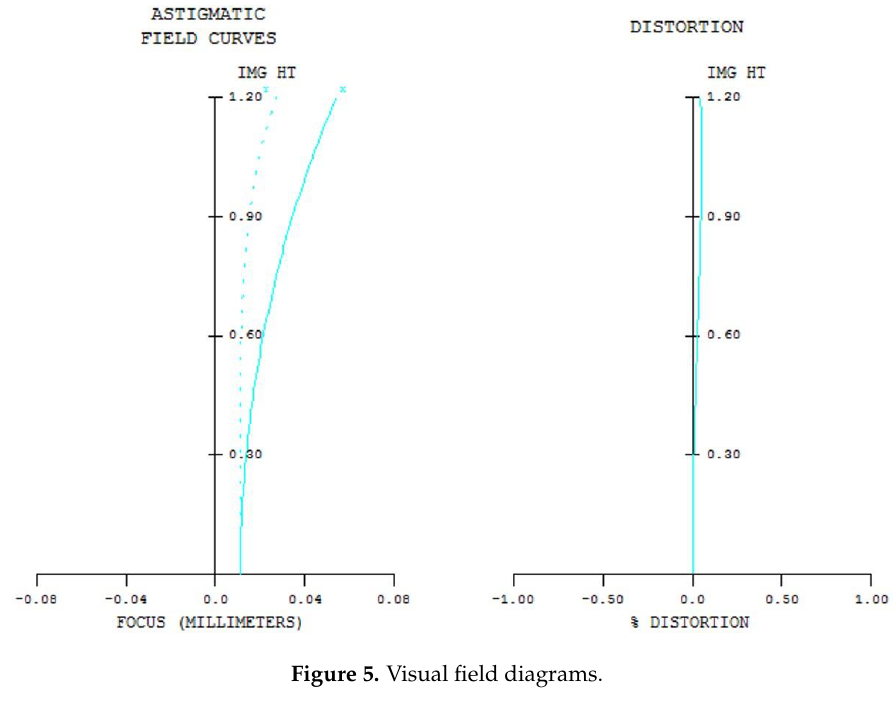
Figure 5. Visual field diagrams.